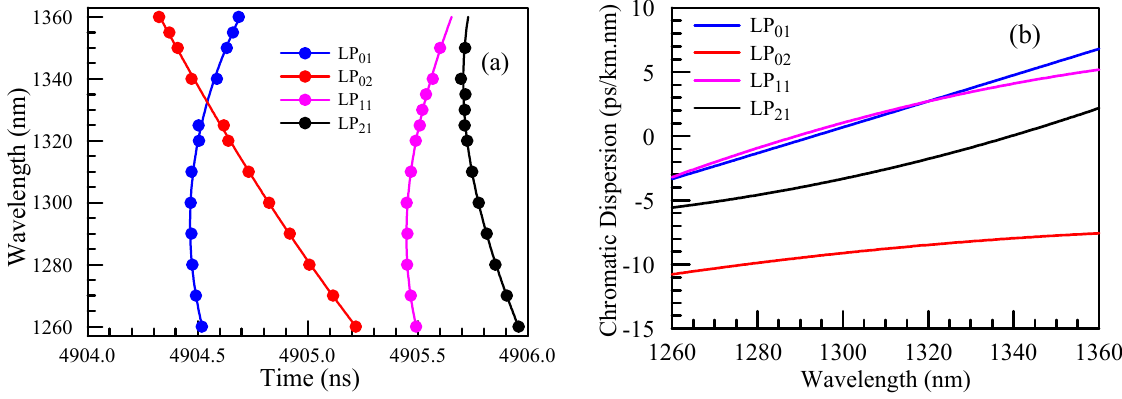
Figure 8. ( a ) Group delay as a function of wavelength. ( b ) Chromatic dispersion as a function of wavelength for the 4-mode FMF over O-band wavelength window.